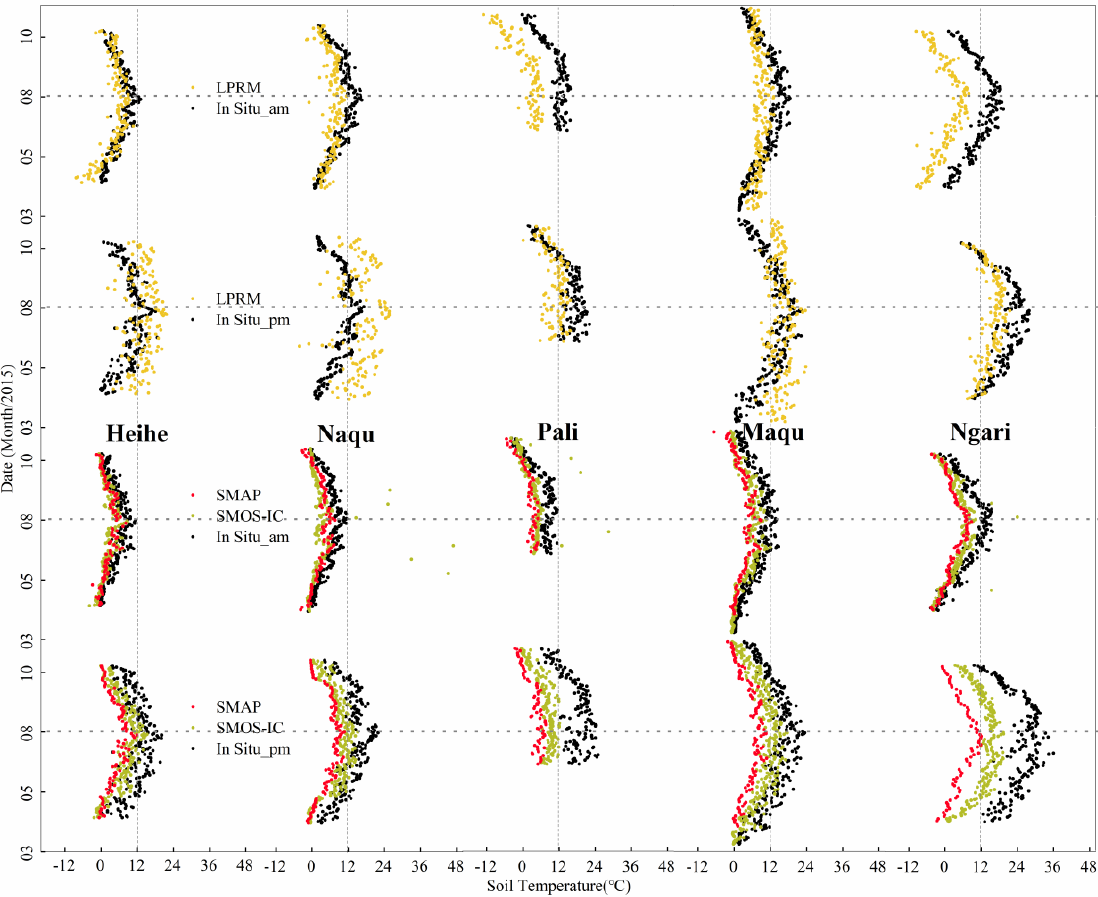
Figure 9. Time series that compare the satellite-based Ts products with respect to the in situ Ts for the morning (nighttime) and afternoon (daytime) orbits for 2015 in five networks.